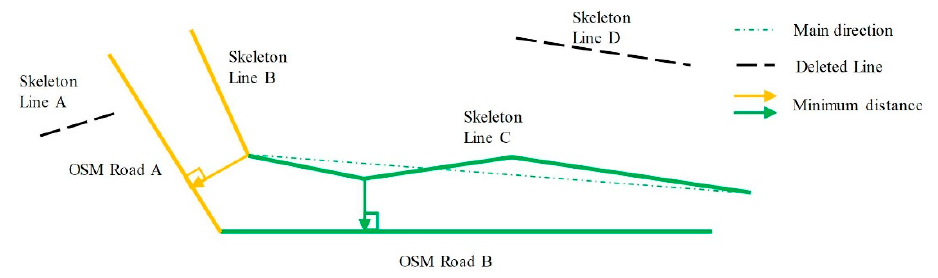
Figure 7. The range of vertical and horizontal (N: north, E: east).